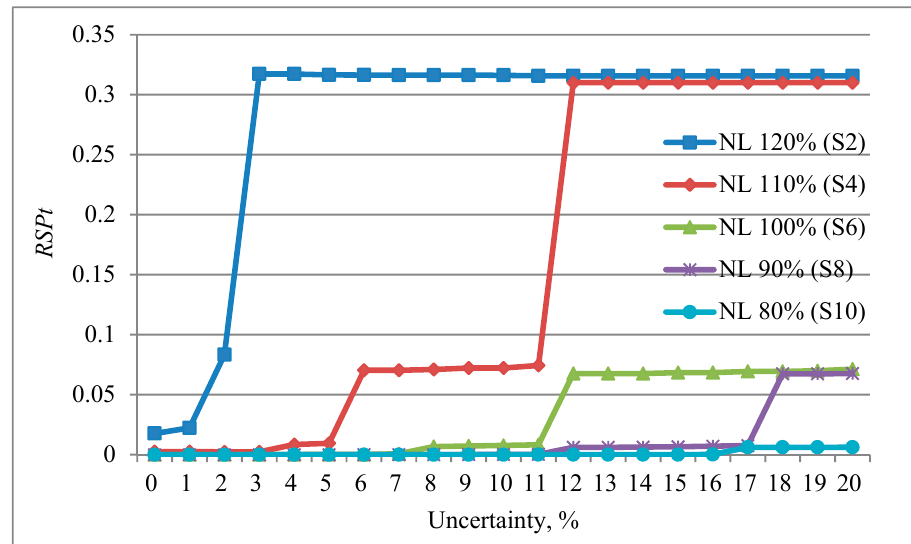
Figure 8. Results of sensitivity analysis for uncertainty.